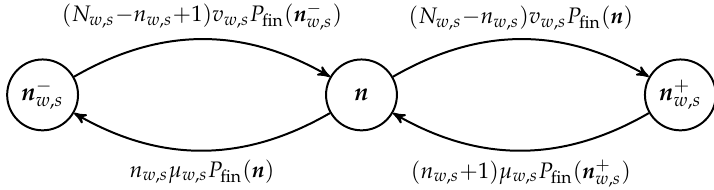
Figure 2. Transition diagram for calls of service class s in the w -th